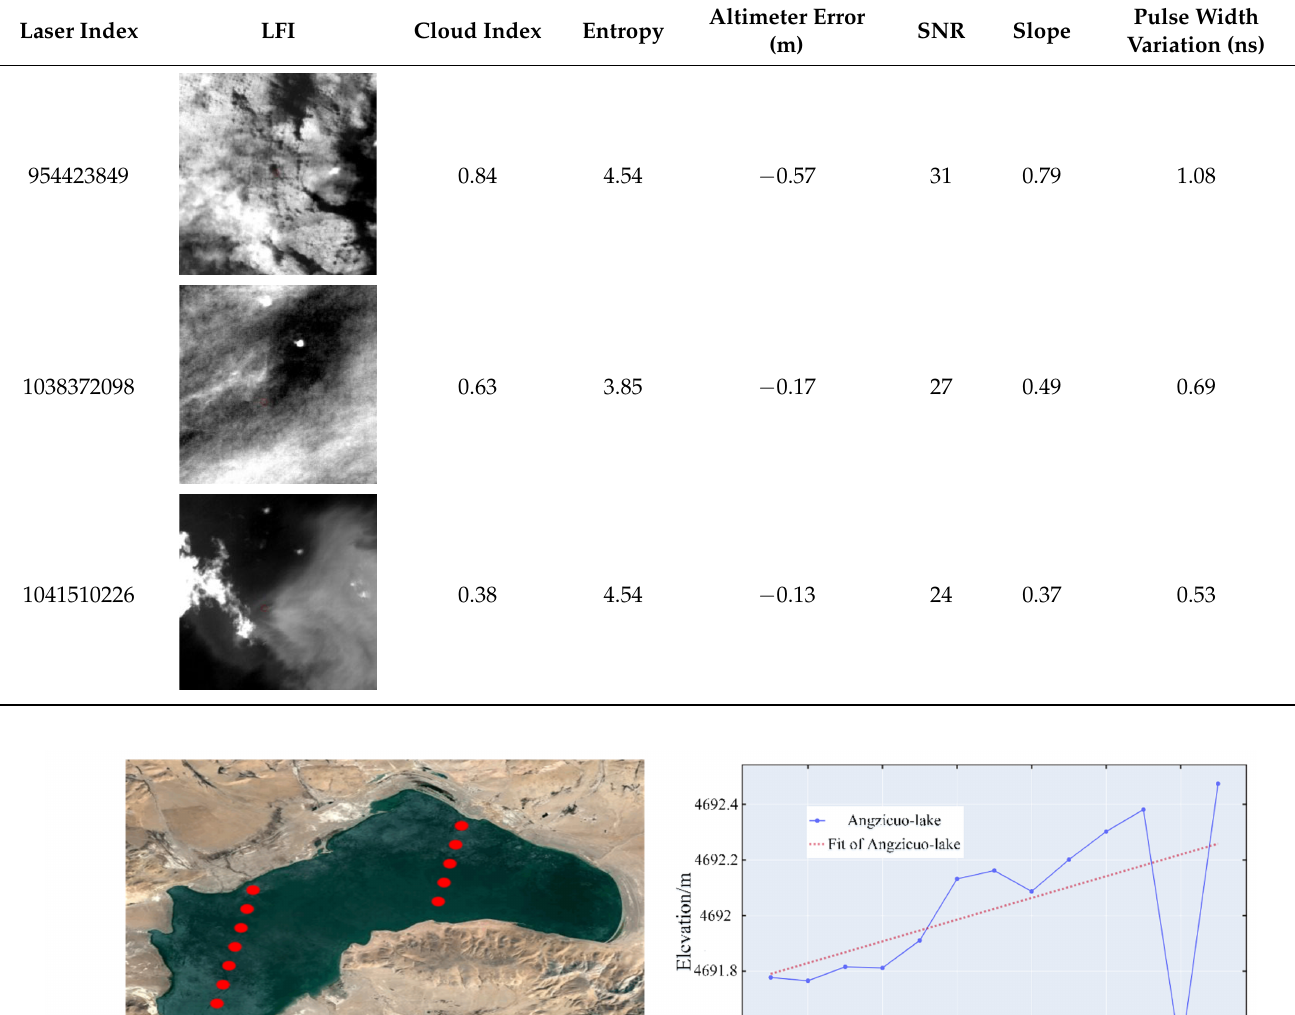
and the terrain exhibits a trend along the track. We fitted the elevation along the track direction, removed the overall trend, and calculated the elevation deviations correspond ‐ ing to each laser point using the fitted results as the actual values. The experimental results indicate that the points were particularly affected by multiple scattering, and the devia ‐ tions in height measurements reached 98 cm. By combining the waveform SNR and ter ‐ rain slope curve along the track, we found that the waveform SNR and slope were abnor ‐ mal when the influence of atmospheric scattering was high.